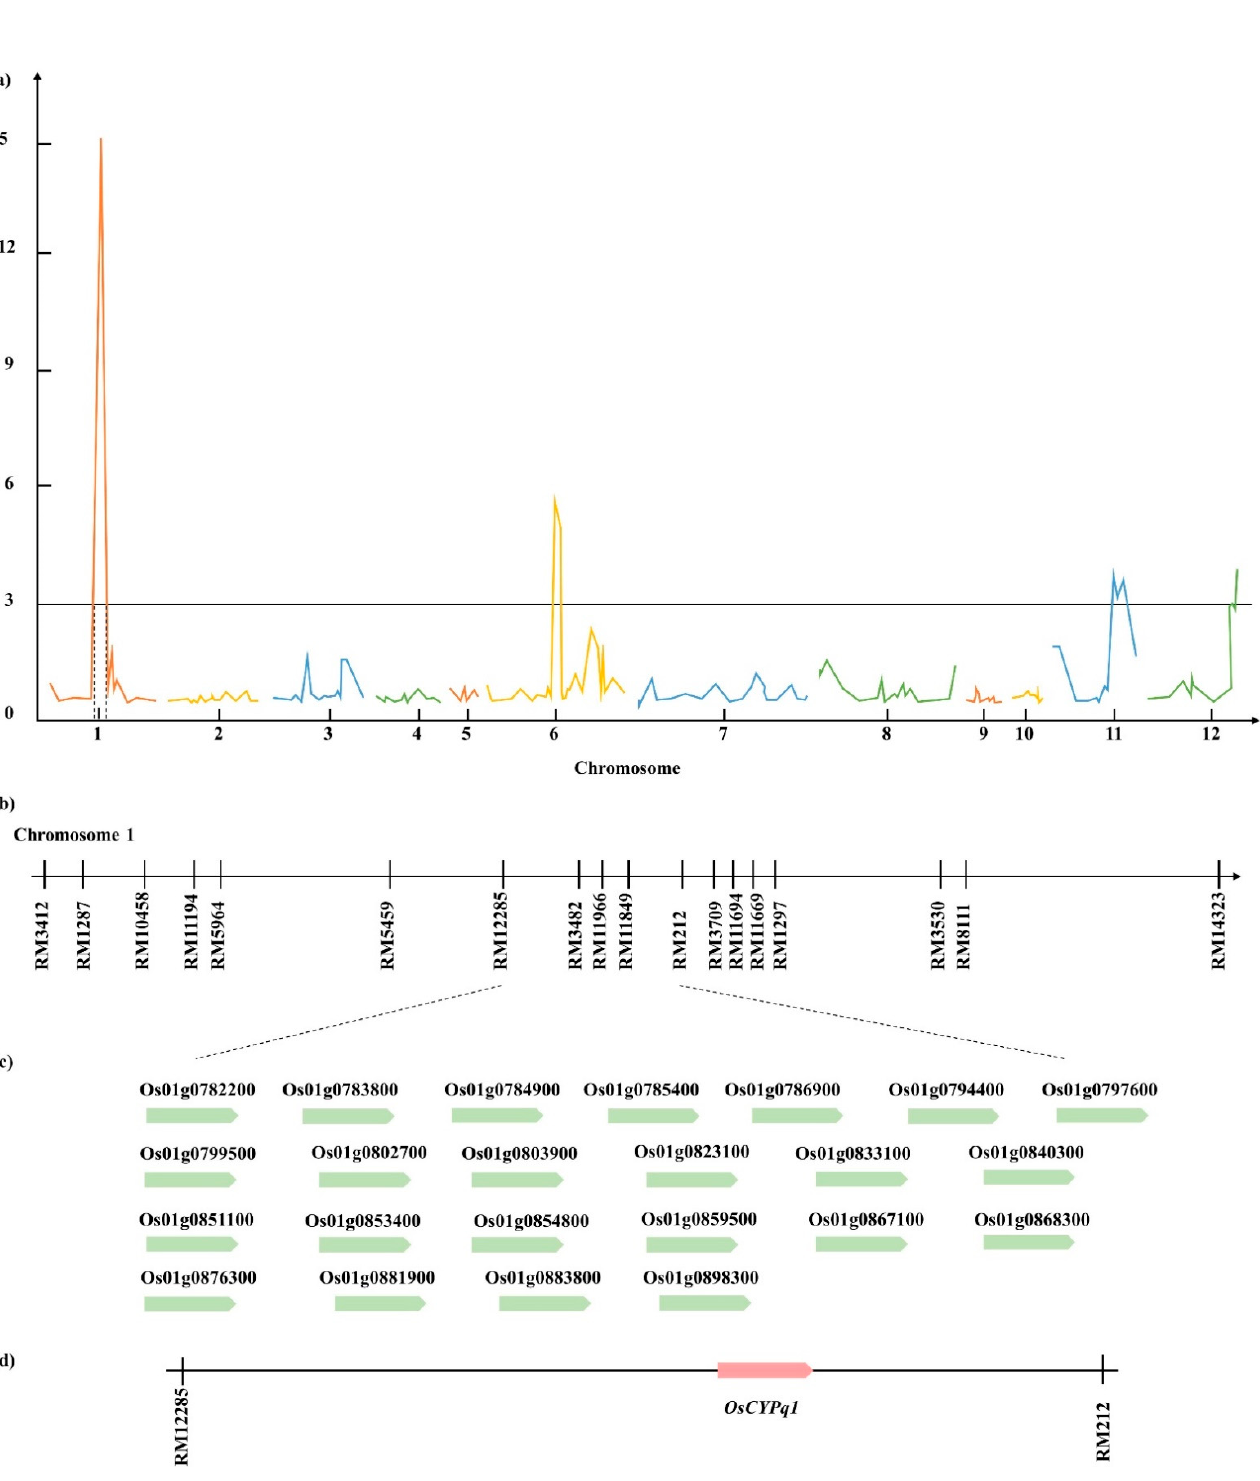
Figure 4. Quantitative trait locus (QTL) analysis and physical mapping of the gene related to the length of the internode. ( a ) Representative QTL analysis for LTI with the highest LOD value 15.17 on chromosome 1 in 2019 was selected. ( b ) The target marker interval RM12285-RM212 on chromosome 1. ( c ) Twenty-three candidate genes were found on chromosome 1 RM12285-RM212. ( d ) Among them, OsCYPq1 was screened as a target gene related to the length of the internode.